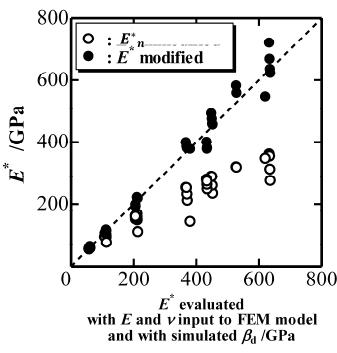
Figure 6. Representative indentation elastic modulus E * estimated with simulated P - h curves plotted against E * evaluated with mechanical properties inputted into the FEM model.